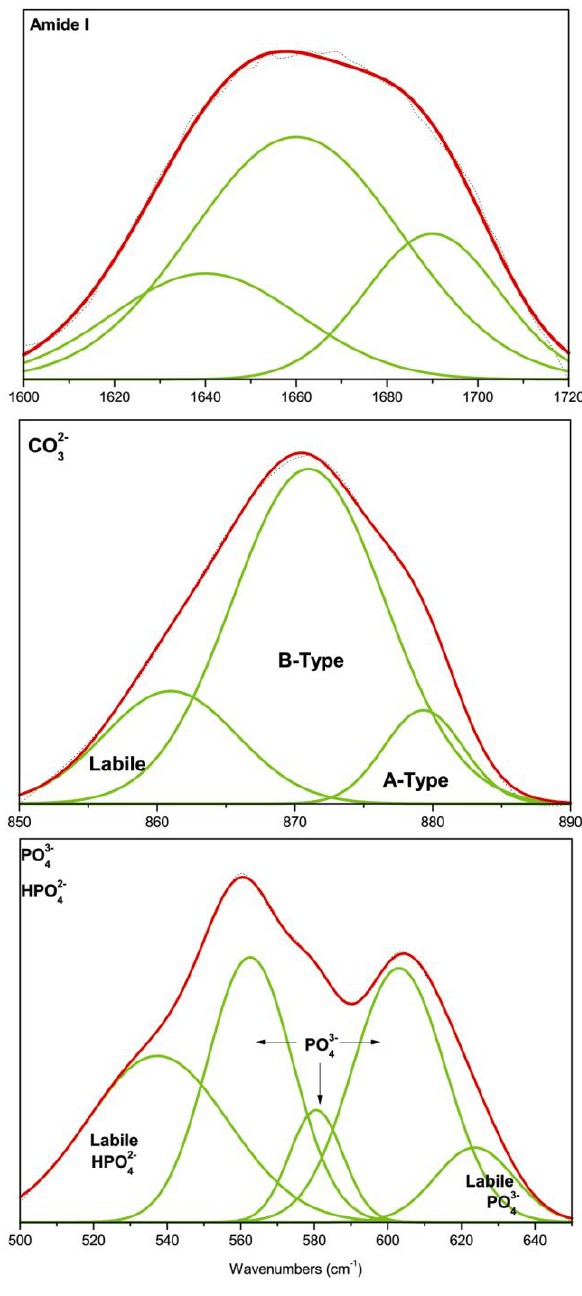
FIGURE 2. Typical curve fitting analysis of PO 43– v 4 , CO 32– v 2 , and Amide I IR